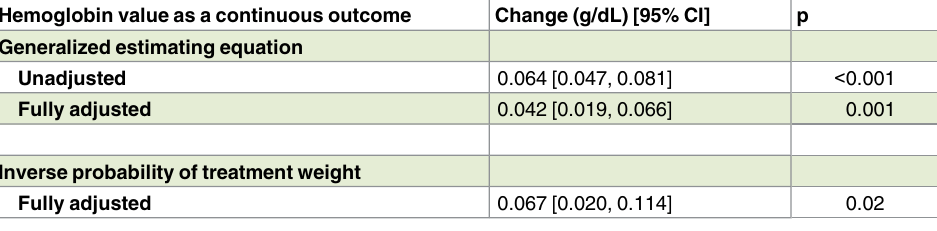
Table 3. Unadjusted and adjusted effectsof each 6 additional months of cinacalcet therapy on hemo- globin levels (intention-to-treat effect). Hemoglobin value as a continuous outcome Change (g/dL) [95% CI] p Generalized estimating equation Unadjusted Fully adjusted Inverse probability of treatment